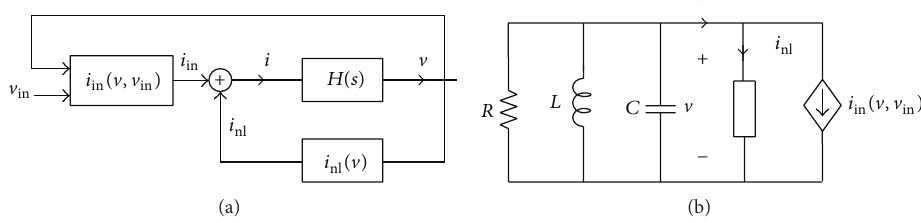
Figure 3: (a) General model of an injection locked frequency divider and (b) its representation as forced 𝐿𝐶 -tank [11].